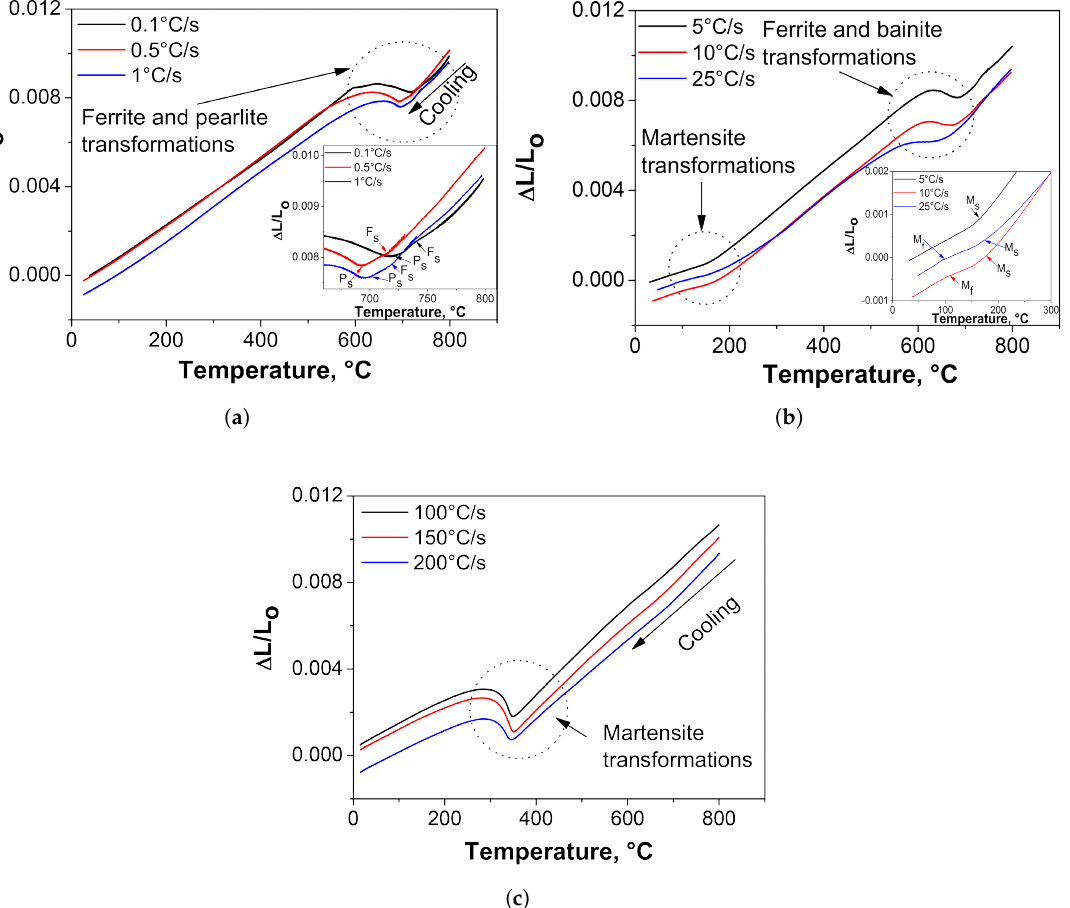
Figure 5. Examples of dilatometric curves obtained at different cooling rates highlighting the phase transformations manifested by changes in the slopes or inflection points on the curves. Cooling rates of: ( a ) 0.1, 0.5, 1 ◦ C/s; ( b ) 5, 10, 25 ◦ C/s; and ( c ) 100, 150 and 200 ◦